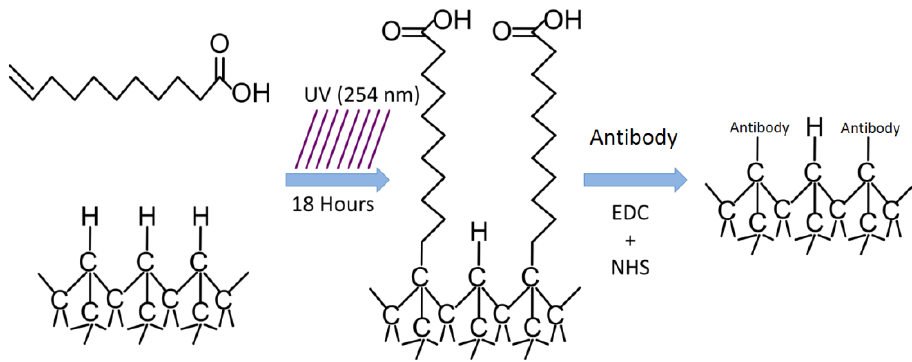
Figure 2. Process fl ow of diamond functionalization for protein detection.